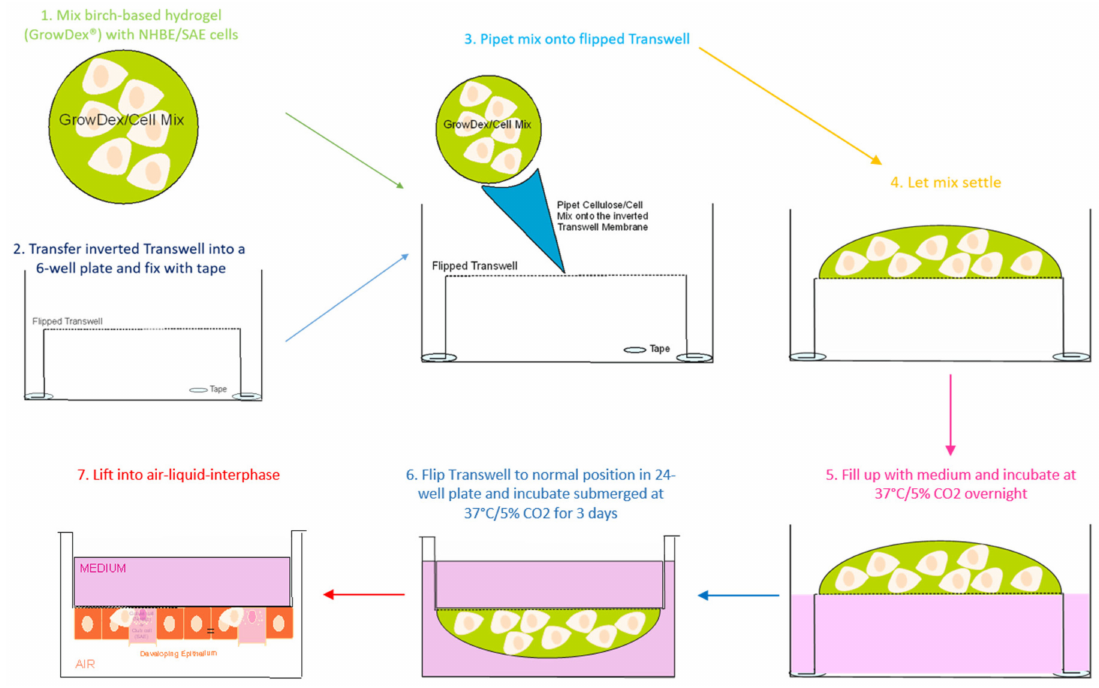
Figure 6. Seeding procedure of primary respiratory cells in cellulose for upside-down cell culture in Transwell chambers. Primary cells (NHBE / SAE) are mixed in GrowDex ® as described below and then transferred to an inverted Transwell chamber fixed with tape in a 6-well plate. Cells are allowed to adhere overnight, and the next day, the Transwell chamber is flipped into a 24-Transwell plate. Cells are cultured submerged for 3 days and then transferred into ALI during the di ff erentiation